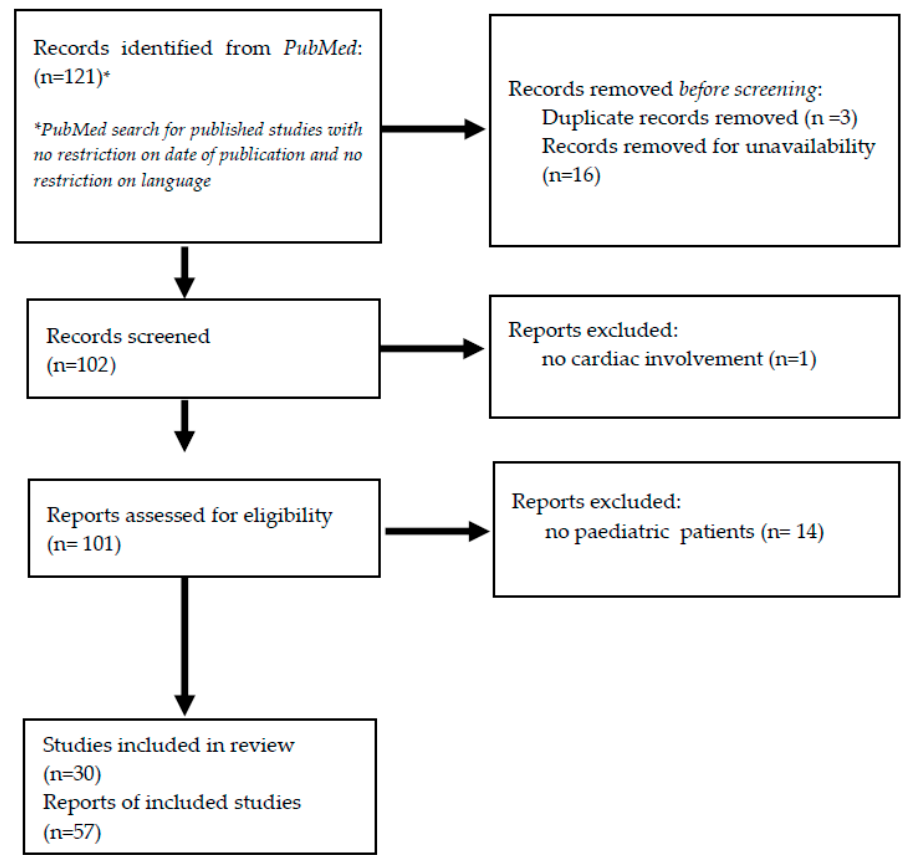
Figure 2. Method used to conduct the literature search for the selected disorders.